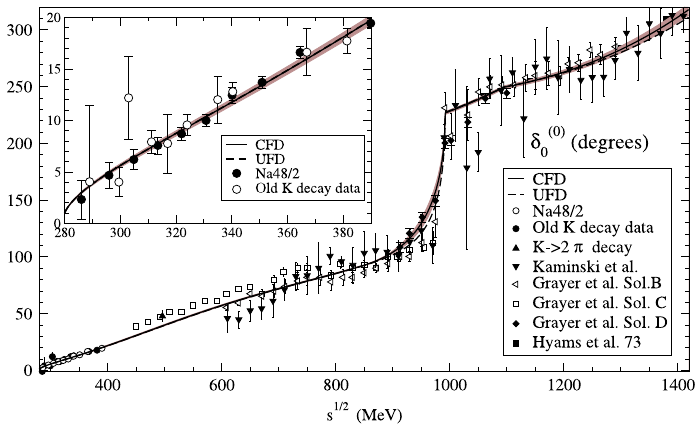
Figure 8. The ππ scalar isoscalar phase shift is well described both with the Unconstrained Fits to Data (UFD) or dispersively Constrained Fits to Data (CFD). Figure taken from